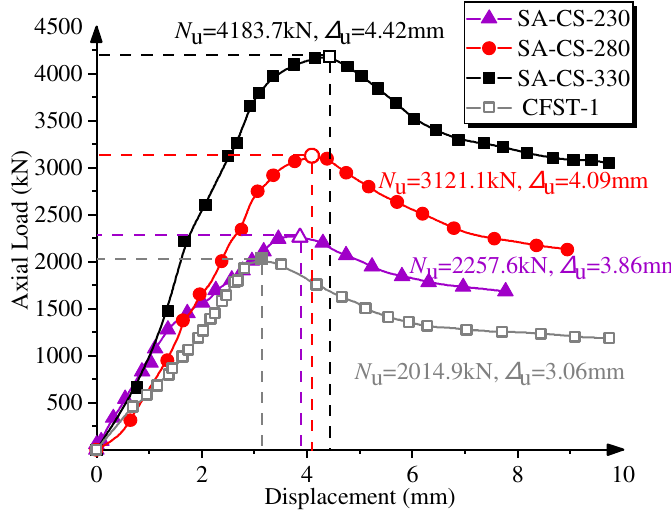
Figure 6. Load-axial displacement curves.